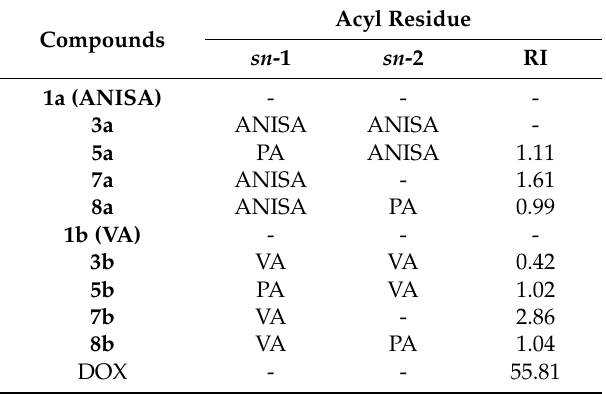
Table 2. Resistance index (RI) values of phenolic-phospholipids. Acyl Compounds